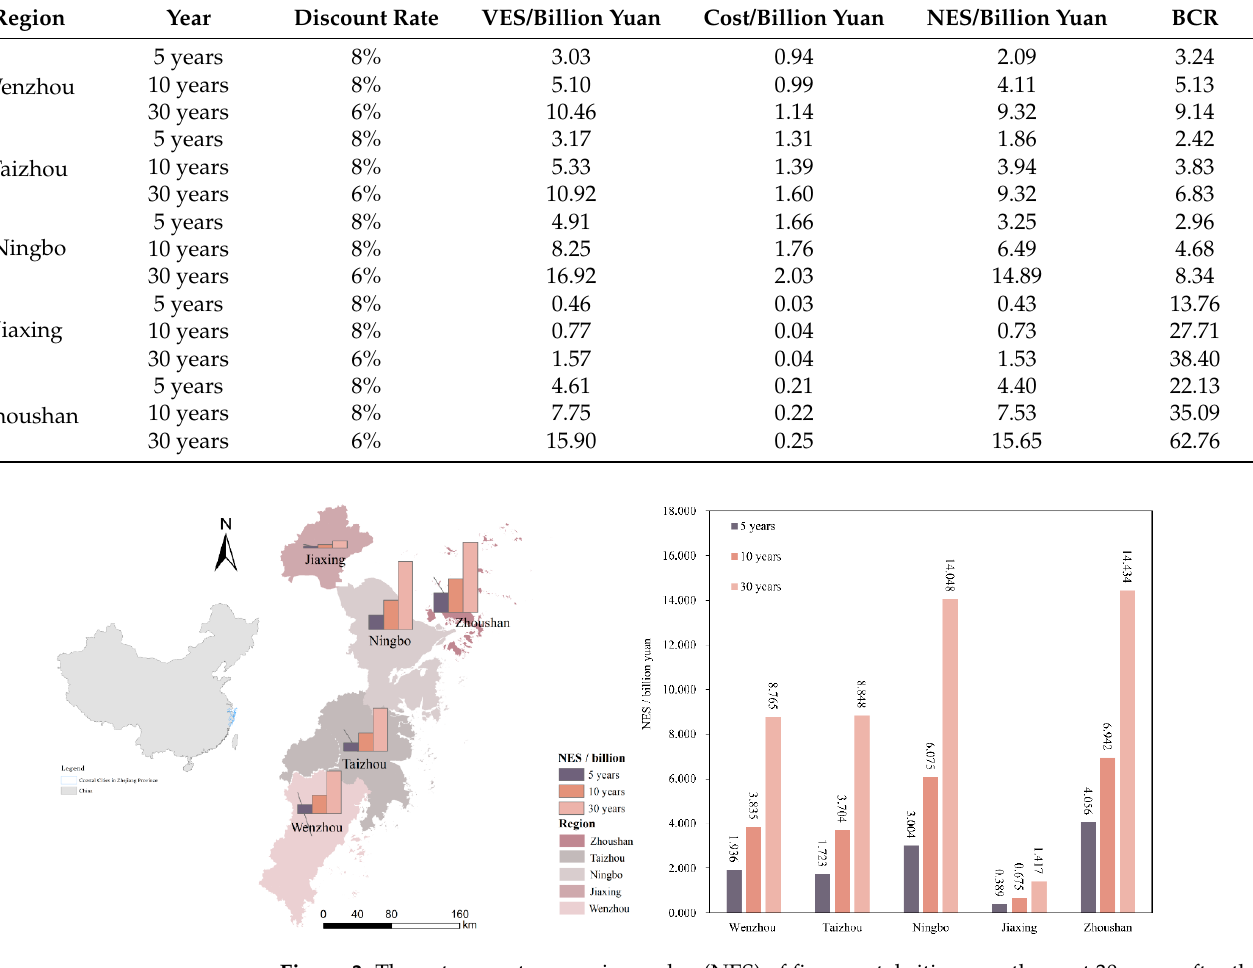
Figure 3. The net ecosystem services value (NES) of five coastal cities over the next 30 years after the project in Zhejiang Province.